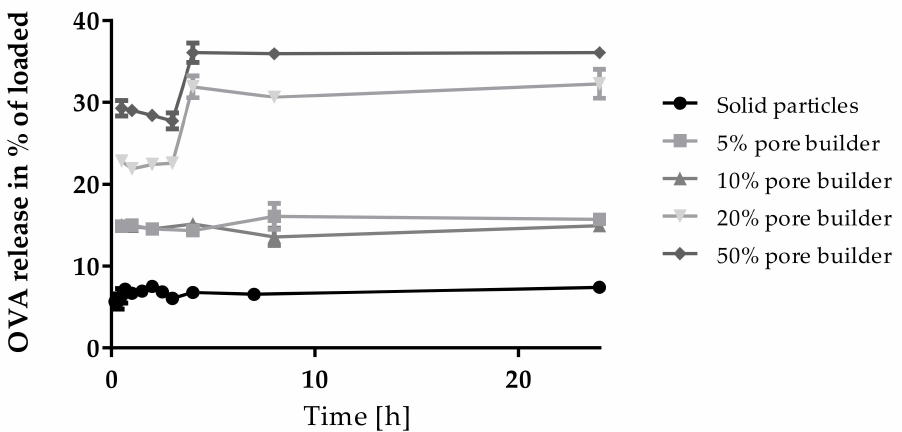
Figure 7. Release of OVA from OVA-loaded PLGA nanoparticles produced by double emulsion technique (without (solid) and with different % amounts of pore builder) in % of loaded OVA over 24 h. n = 3, error bars are standard deviation.